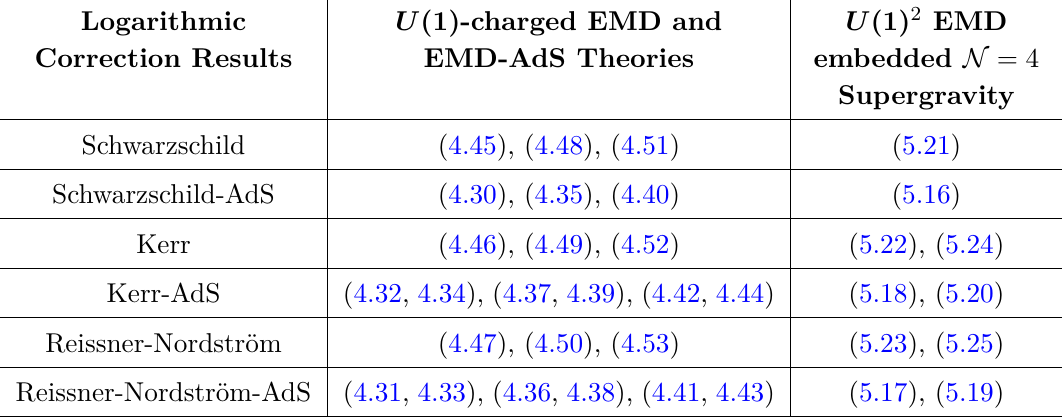
Table 1. The list of logarithmic entropy correction results for extremal and non-extremal